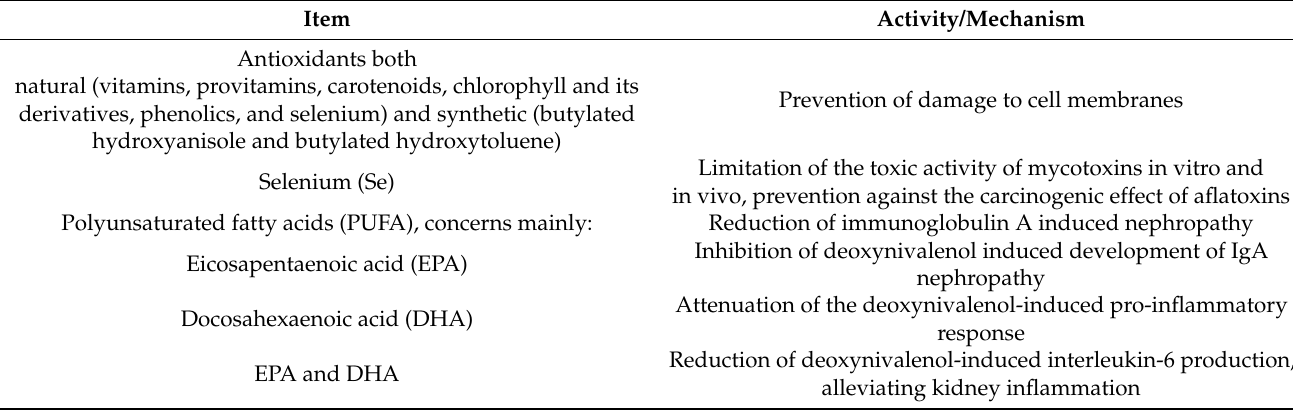
Table 2. Food additives for the diet against mycotoxins. Based on